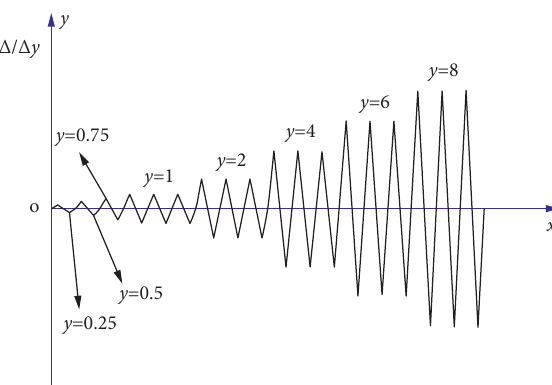
Figure 6: Horizontal loading Table 3: Failure modes of the specimens.